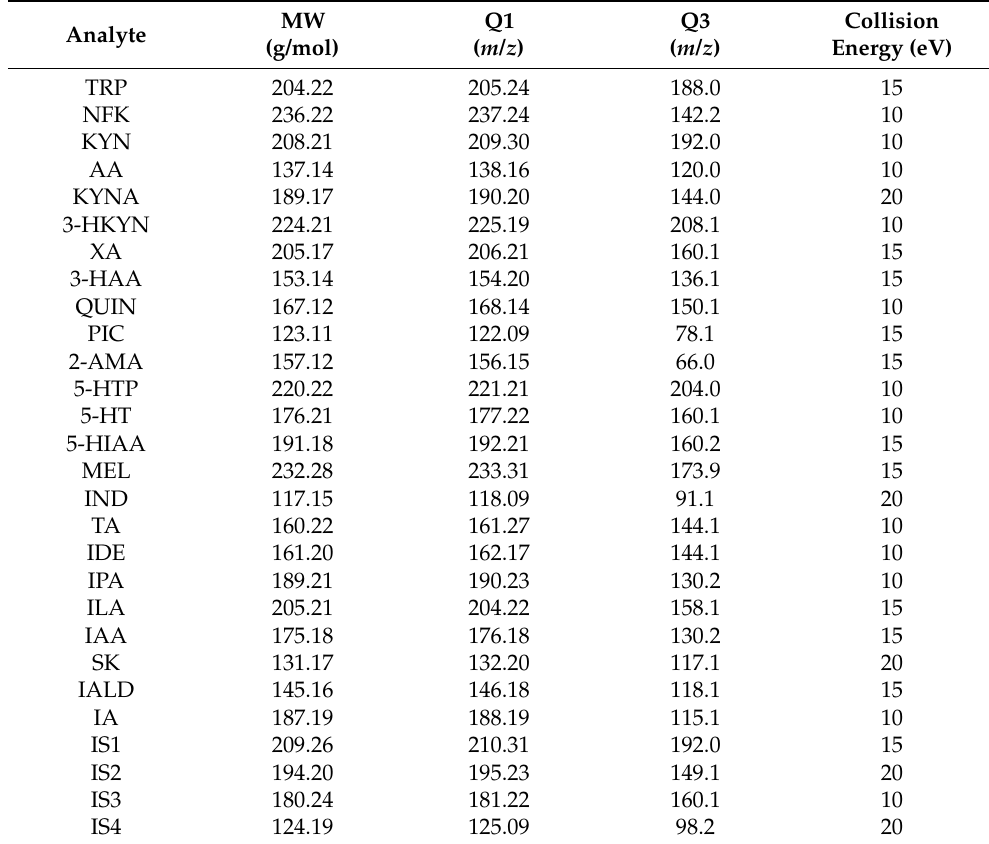
Table 1. Multiple reaction monitoring (MRM) transitions and compound-specific MS